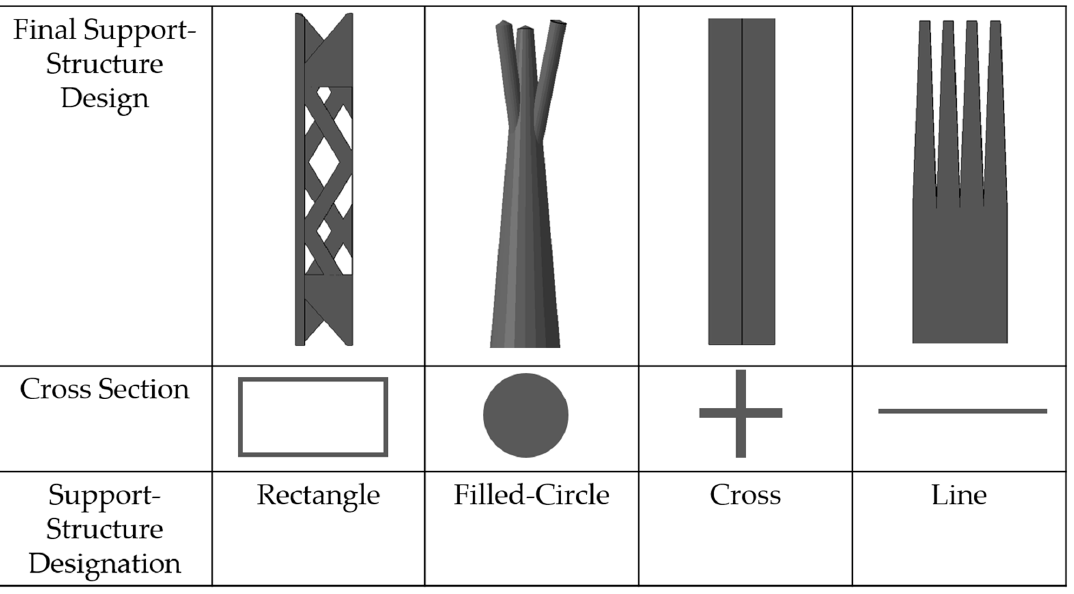
Figure 5. Final design, cross-section, and the designation of support Figure 5 . Final design, cross-section, and the designation of support structures .